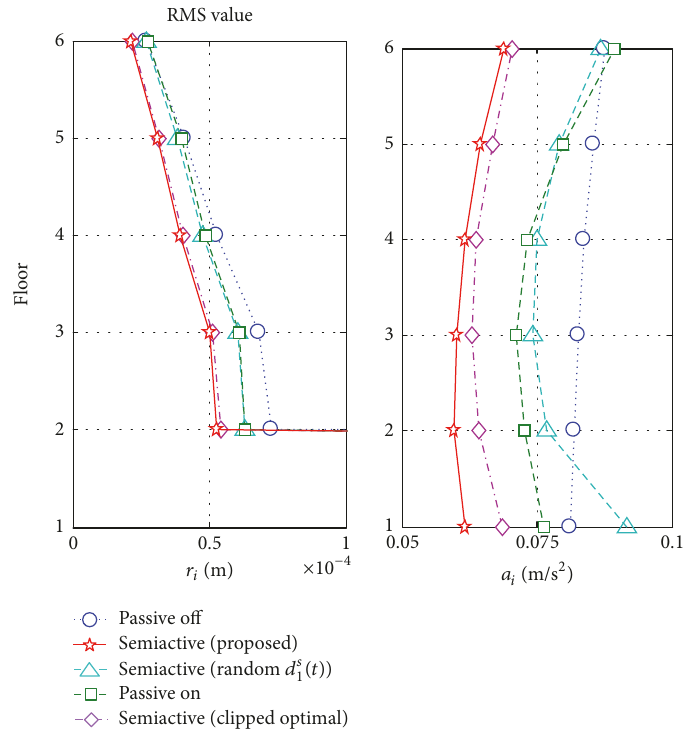
Figure 7: Simulation results for the El Centro NS (1940) earthquake disturbance; RMS values of the relative displacement between neighboring floors and absolute acceleration of each